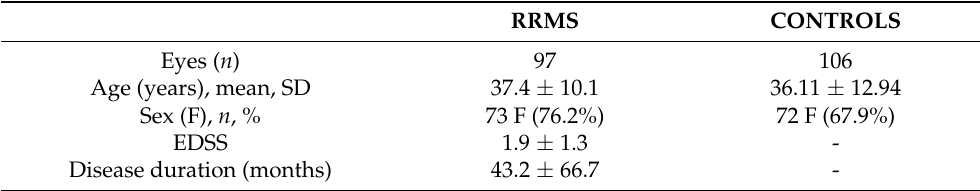
Table 1. Demographic and clinical data of relapsing remitting MS patients and the control group.